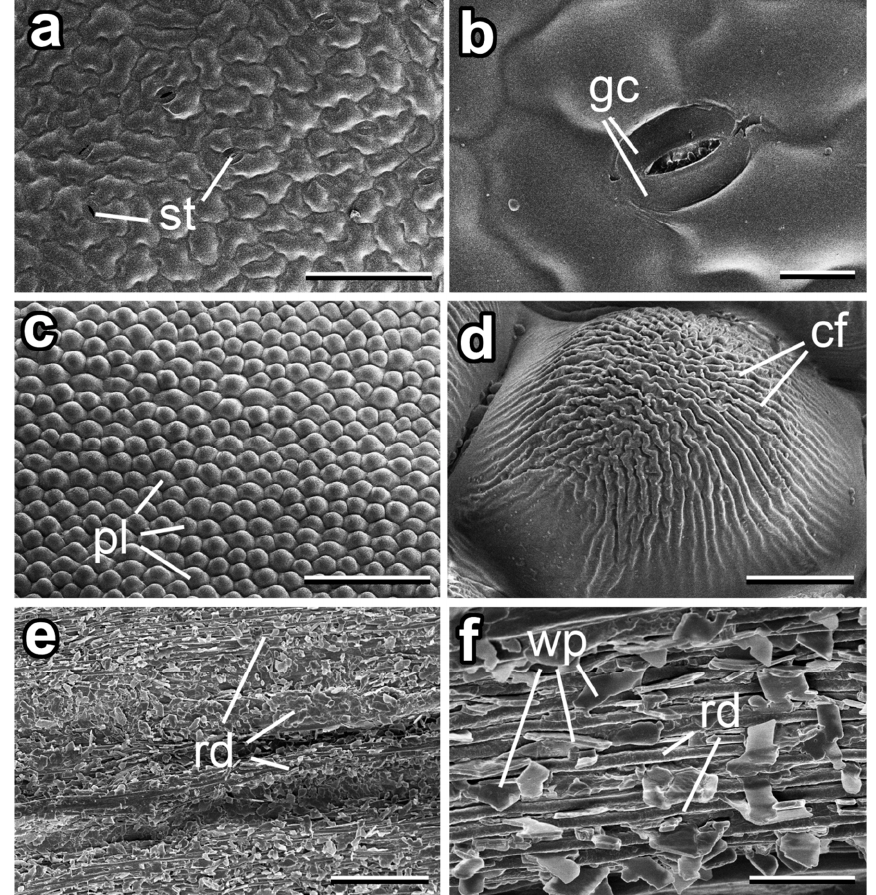
Figure 3. Surfaces of different organs in the plant Dahlia pinnata (cryo-SEM). ( a , b ) Adaxial leaf side. ( c , d ) Adaxial petal side. ( e , f ). Stem. Abbreviations: cf, cuticular folds; gc, guard cells of the stoma; pl, papillae; rd, ridges; st, stomata; wp, epicuticular wax plates. Scale bars: 200 µm ( a , c ), 20 µm ( b , e ), 10 µm ( d ), 5 µm ( f ).